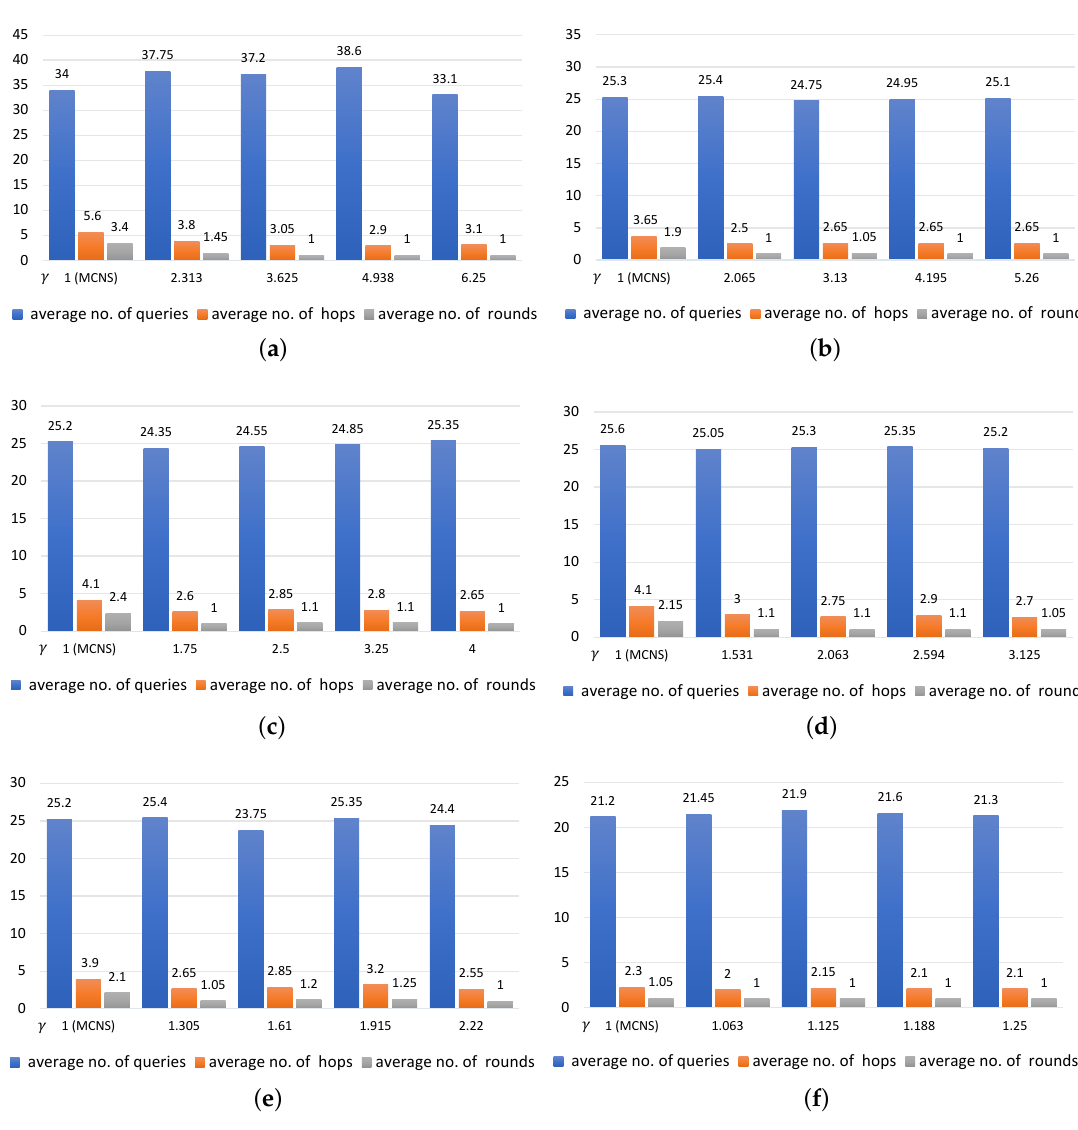
Figure 7. Comparing MCNS and MCNS-G: the number of queries sent to regions and number of hops and number of rounds averaged over 20 runs (vertical axis)for varying γ (horizontal axis) for different values of σ with k = 20. ( a ) σ = 0.16 ( α = 0.20 , β = 0.80 ) ; ( b ) σ = 0.19 ( α = 0.75 , β = 0.25 ) ; ( c ) σ = 0.25 ( α = 0.50 , β = 0.50 ) ; ( d ) σ = 0.32 ( α = 0.80 , β = 0.40 ) ; ( e ) σ = 0.45 ( α = 0.60 , β = 0.75 ) ; ( f ) σ = 0.81 ( α = 0.90 , β = 0.90 )